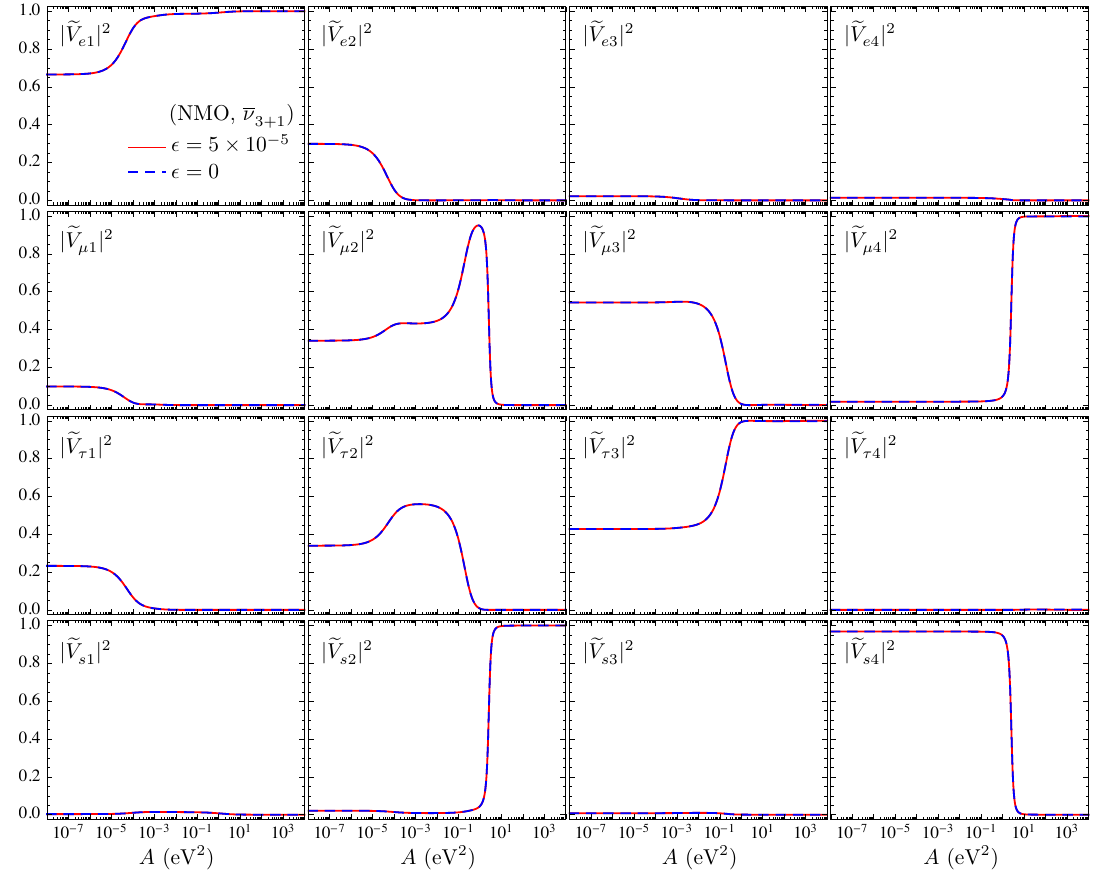
2 (for (cid:11) = e; (cid:22); (cid:28); s and i = V (cid:11)i j j ) with or without 3+1 e ; (cid:18) ; (cid:18) ; (cid:14); (cid:1) ; (cid:1) ) [36, 37], 12 13 23 21 31 ; (cid:18) ; (cid:18) ) = (6 : 66 (cid:14) ; 7 : 81 (cid:14) ; 0), (cid:14) = (cid:14) = (cid:14) = 0, 14 24 34 14 24 34